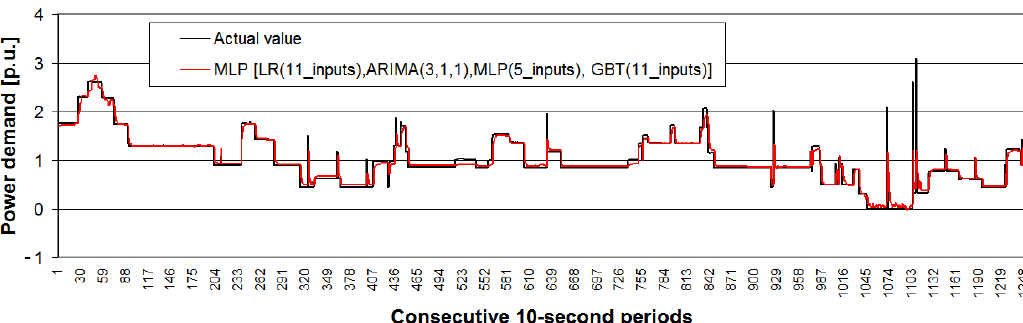
Figure 13. Actual values from the test range (subset) of time series No. 2 and the forecast values by the best method.